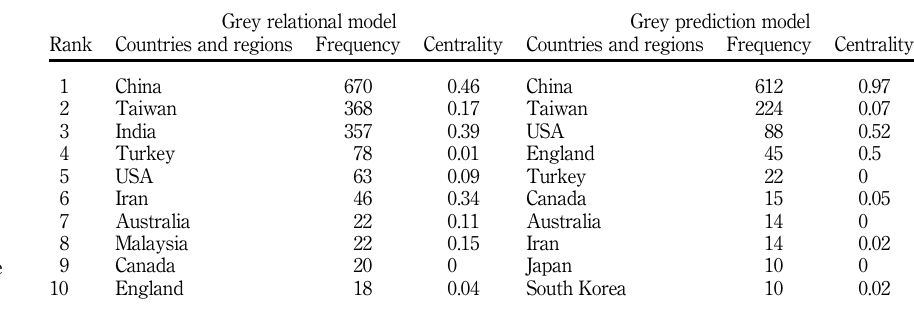
Table IV. Top 10 countries and regions on the grey model